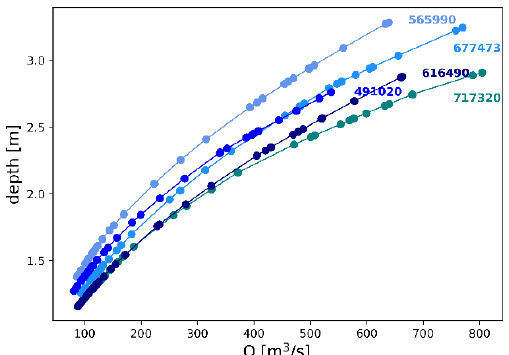
Figure 10. Examples of simulated rating curves relating WSE and discharge at different chainage points.